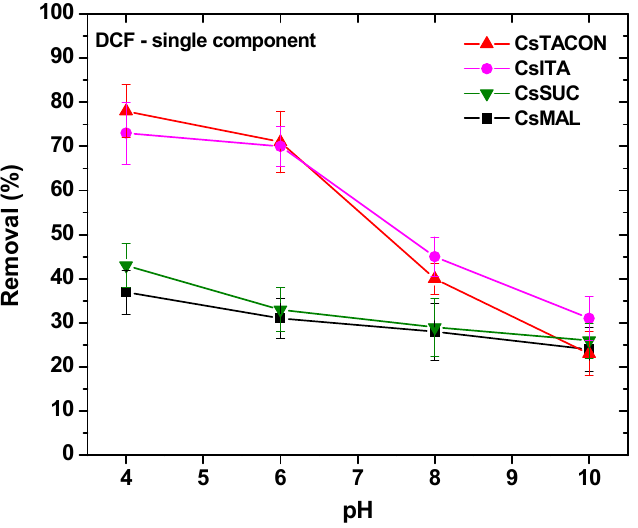
Figure 7. Effect of pH on the removal of DCF by chitosan adsorbents.